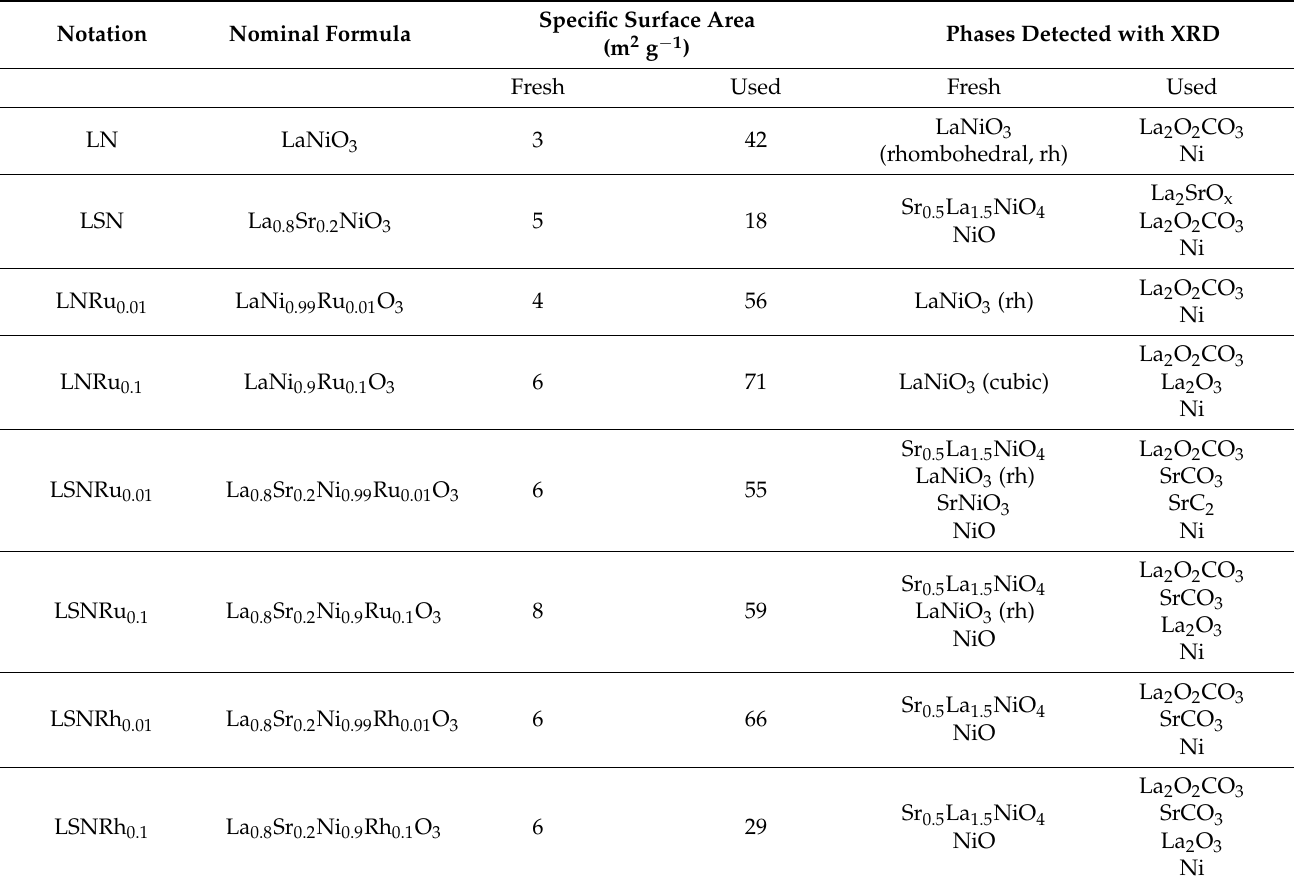
Table 1. Notation, nominal composition, BET specific surface area, and main phases detected with XRD for the as-prepared (fresh) perovskites and the used